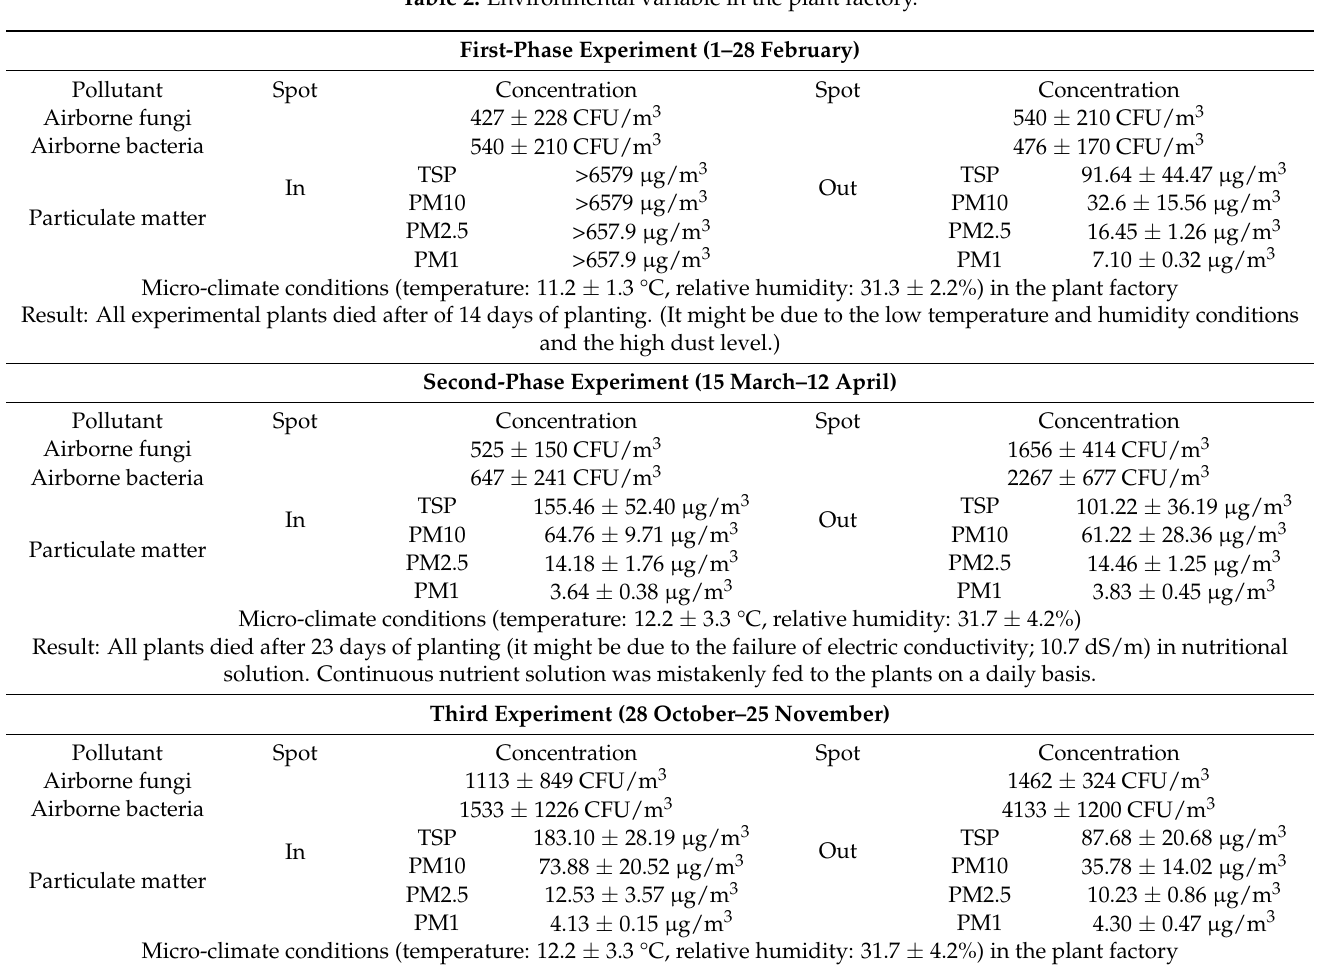
Table 2. Environmental variable in the plant